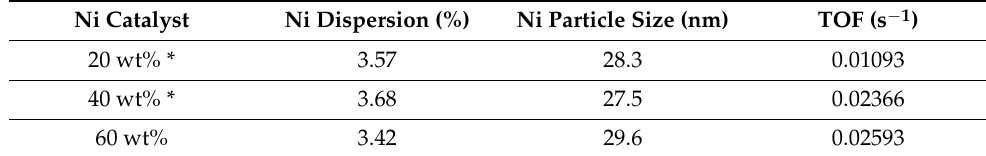
Table 3. Ni dispersion, particle size, and TOF for the 20, 40, and 60 wt% Ni-Mg-Al catalysts. Ni Catalyst Ni Dispersion (%) Ni Particle Size (nm) TOF (s − 1 ) 20 wt% * 3.57 28.3 0.01093 40 wt% * 3.68 27.5 0.02366 60 wt% 3.42 29.6 0.02593